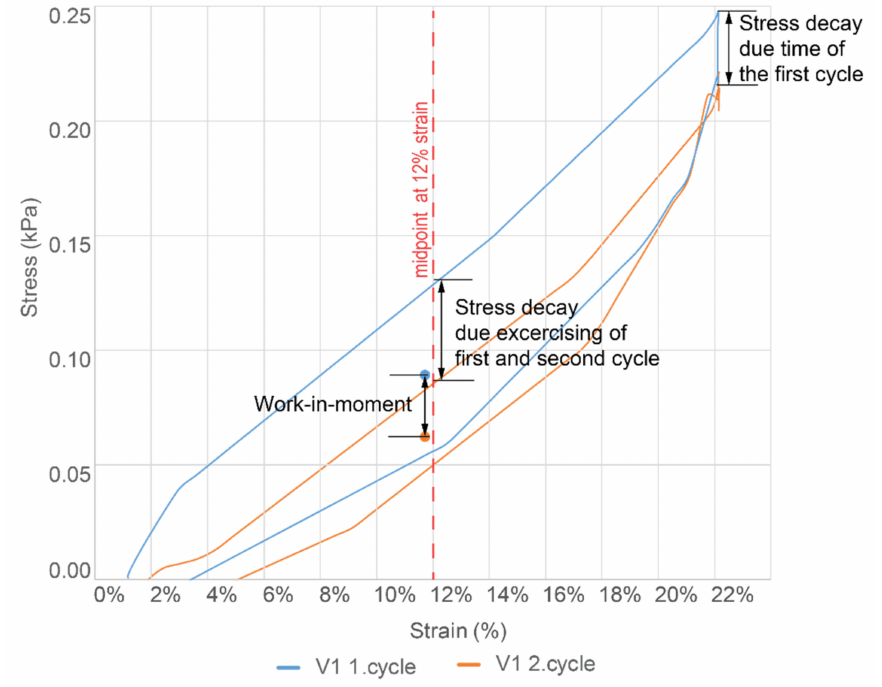
Figure 5. Stress-Strain curve example of the first two cycles from V1, indicating the midpoint position at strain 12%, which was used as the measuring point for determining Young’s modulus (E) and Work-in-moment (WiM). Three characteristics and where they are measured is also